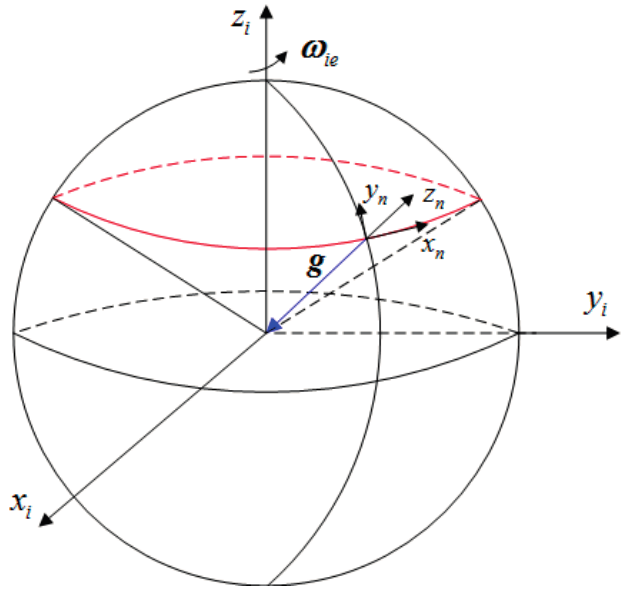
Figure 1. The moving trajectory of gravity in the inertial